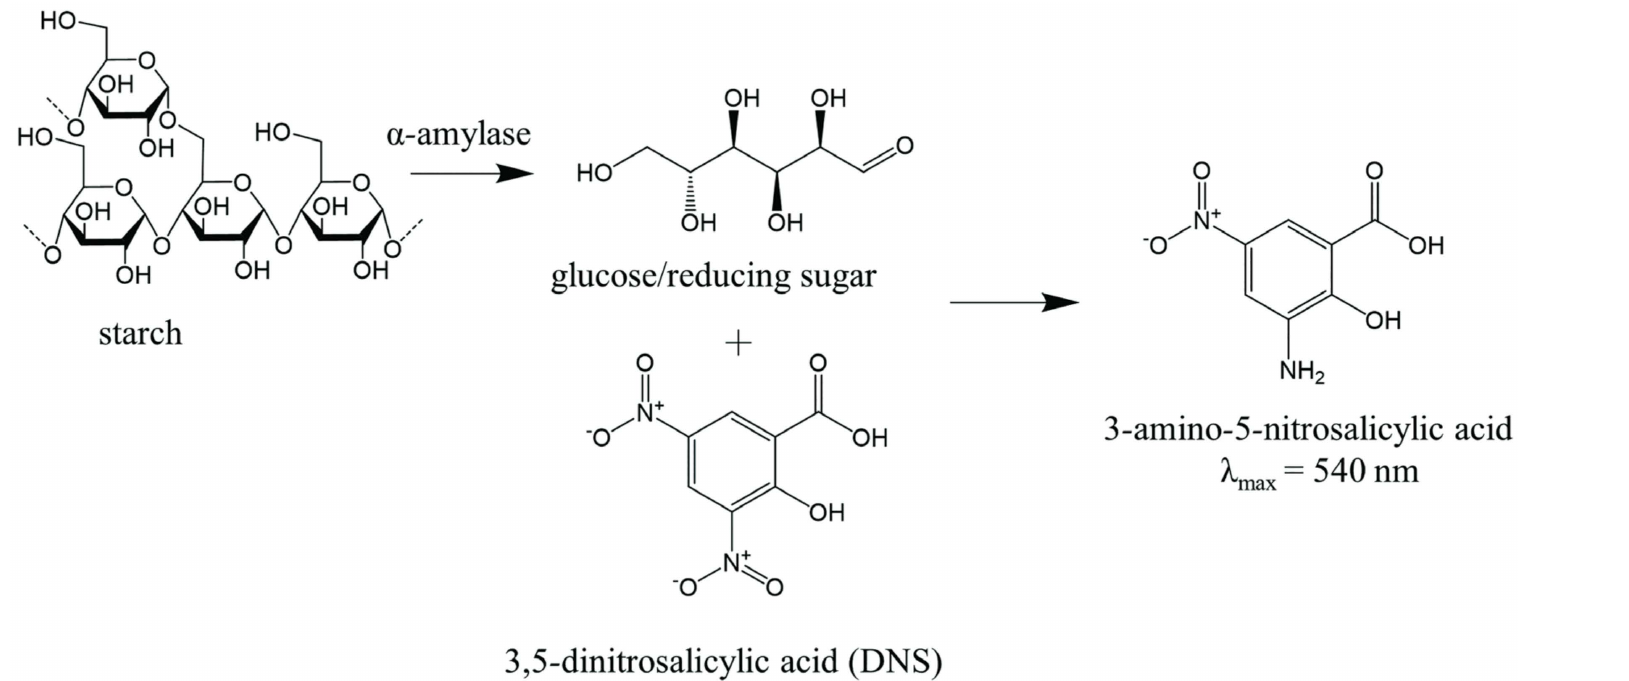
Figure 2. The DNS-based method used to evaluate α -amylase inhibitors in medicinal plant extracts. The figure was generated using ChemDraw Professional